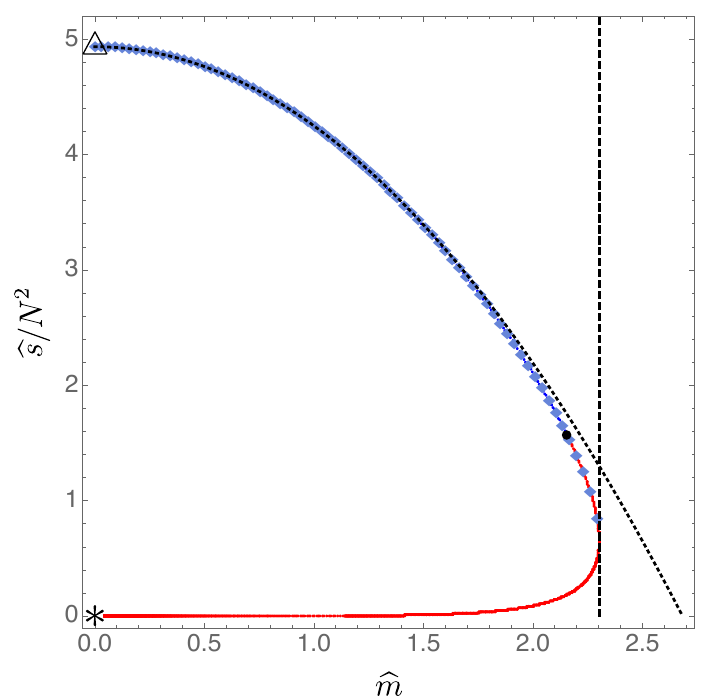
Figure 10 . The conformally-invariant entropy density mass deformation m : comparing the d = 5 and d = 10 supergravity results. The (red continuous b line) d = 5 results were already shown in (cid:12)gure 1, but here we also add the IIB results (blue diamond curve which is on the top of 5d results), and we also plot the second-order (in result (4.51) depicted here as a dashed black line. We use the same color and symbol codes as in the captions of previous (cid:12)gures 1{7. Namely, the vertical dashed line intersects the turning point at m = m t (cid:24) 2 : 30; see (3.31). The triangle 4 (with b b